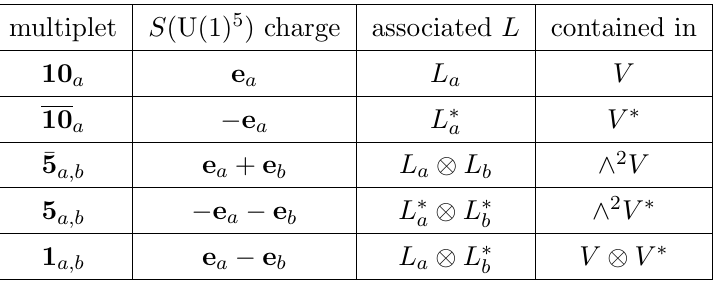
Table 2 . A list of SU(5) (cid:2) S (U(1) 5 ) multiplets in the low-energy theory and their associated line bundles. The multiplicity of each multiplet is computed by the cohomology h 1 ( X; L ) of the associated line bundle L